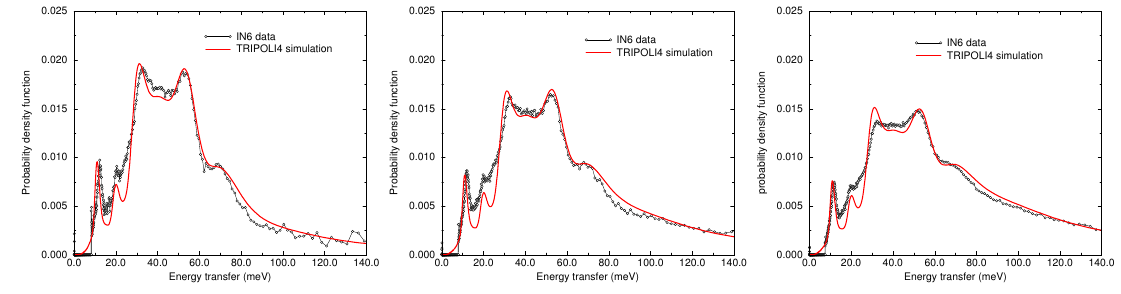
Figure 3. (Color online) Experimental PDOS for UO 2 at 300 K, 600 K and 900 K measured at ILL and SNS [7].